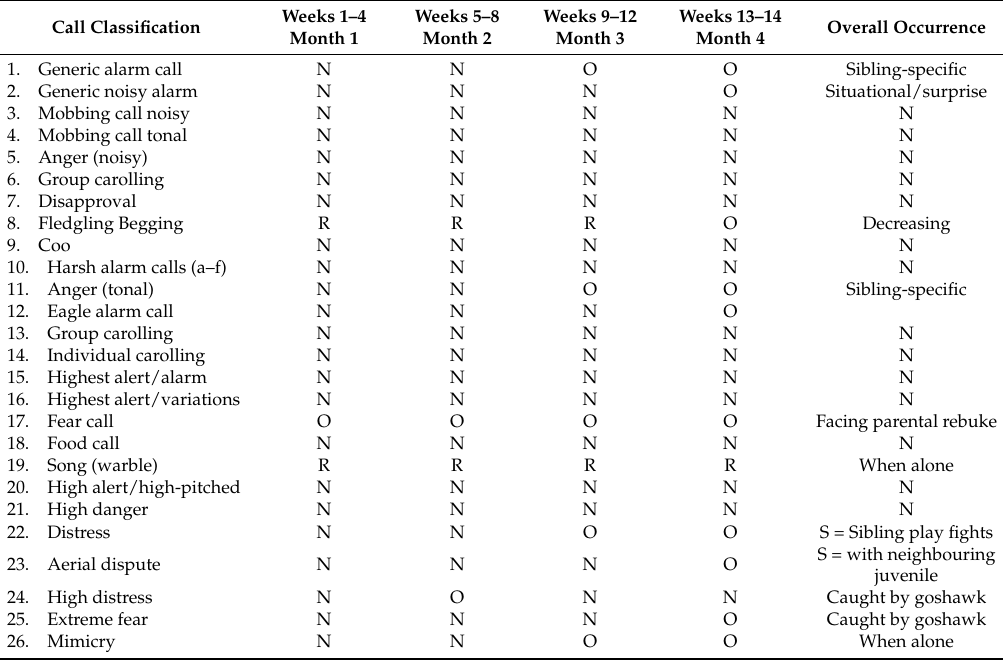
Table 1. Post-fledging sound production development. Call classifications presented in same order as in Figure 9 above. N: The category “never”; O: “Occasional”, included any sounds recorded to be produced by juveniles twice per month and up to once per week. R: “Regular”, meant voicing specific sounds at least once per week or